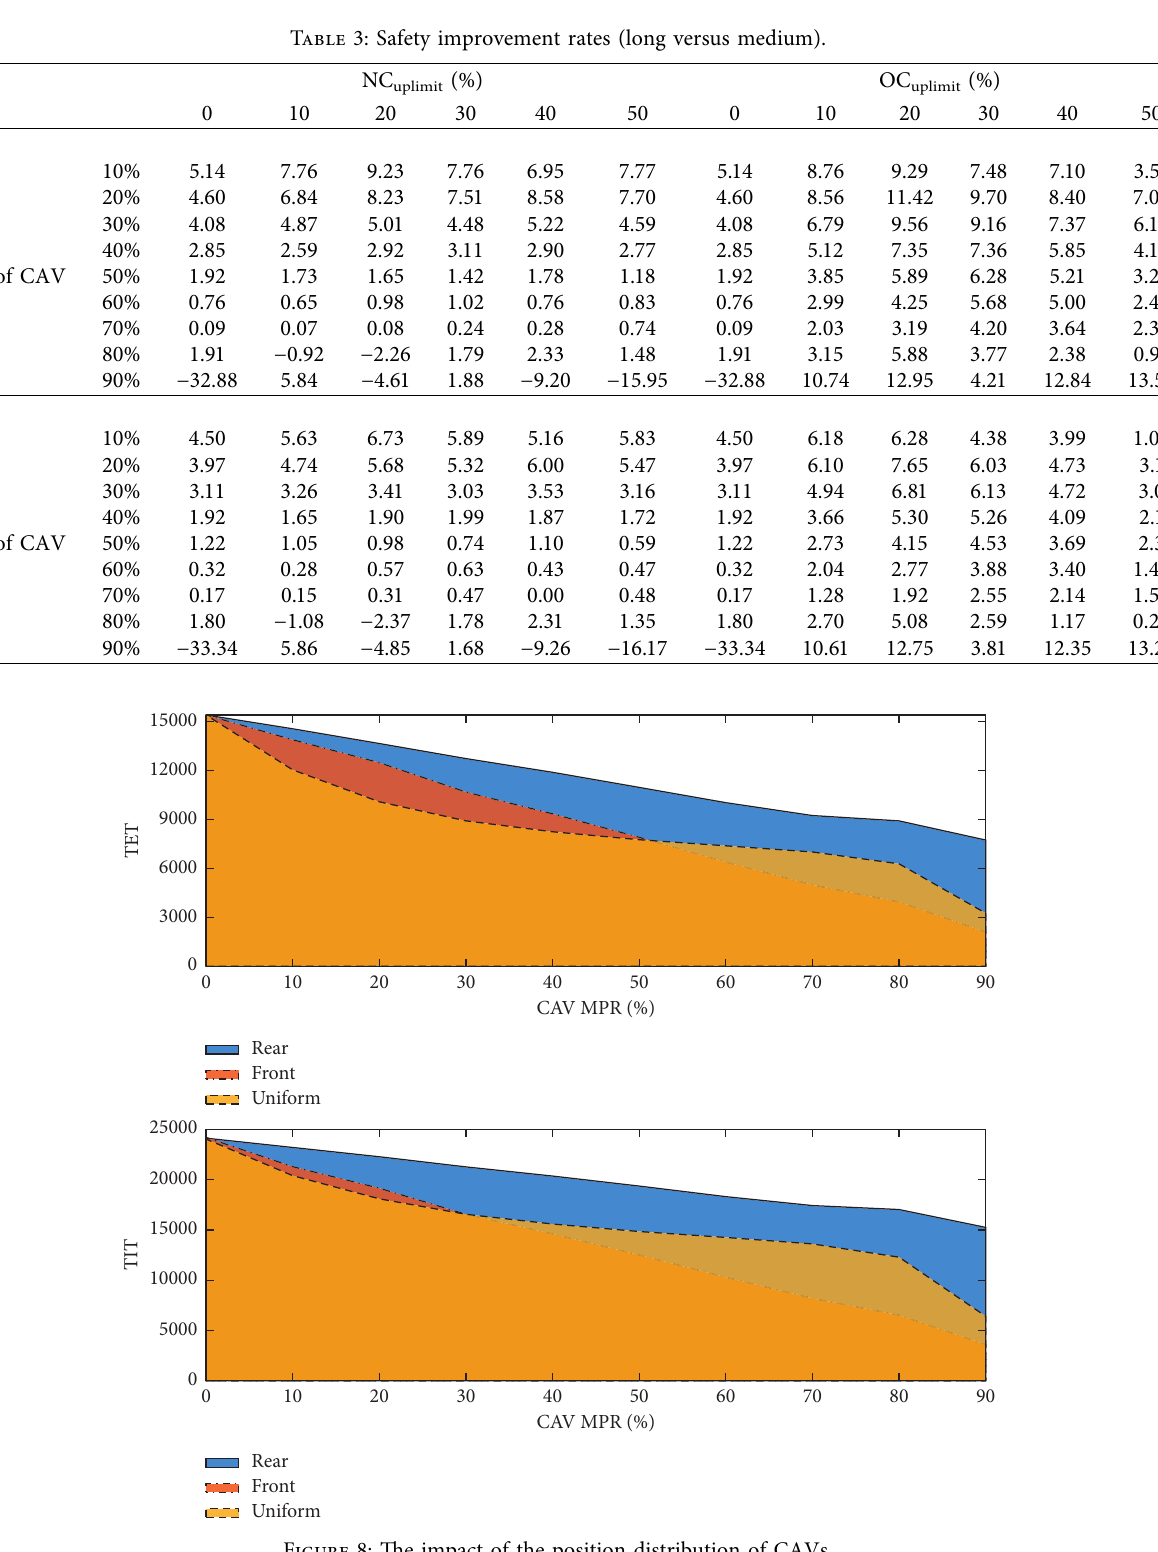
Figure 8: The impact of the position distribution of